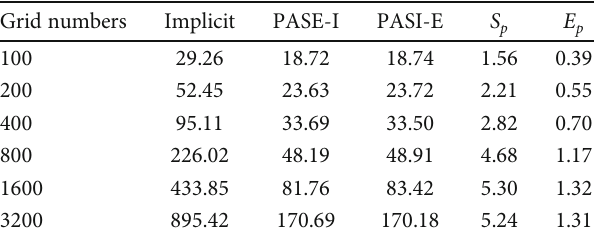
Table 3: Comparison of the three di ff erence schemes ’ CPU time. Grid